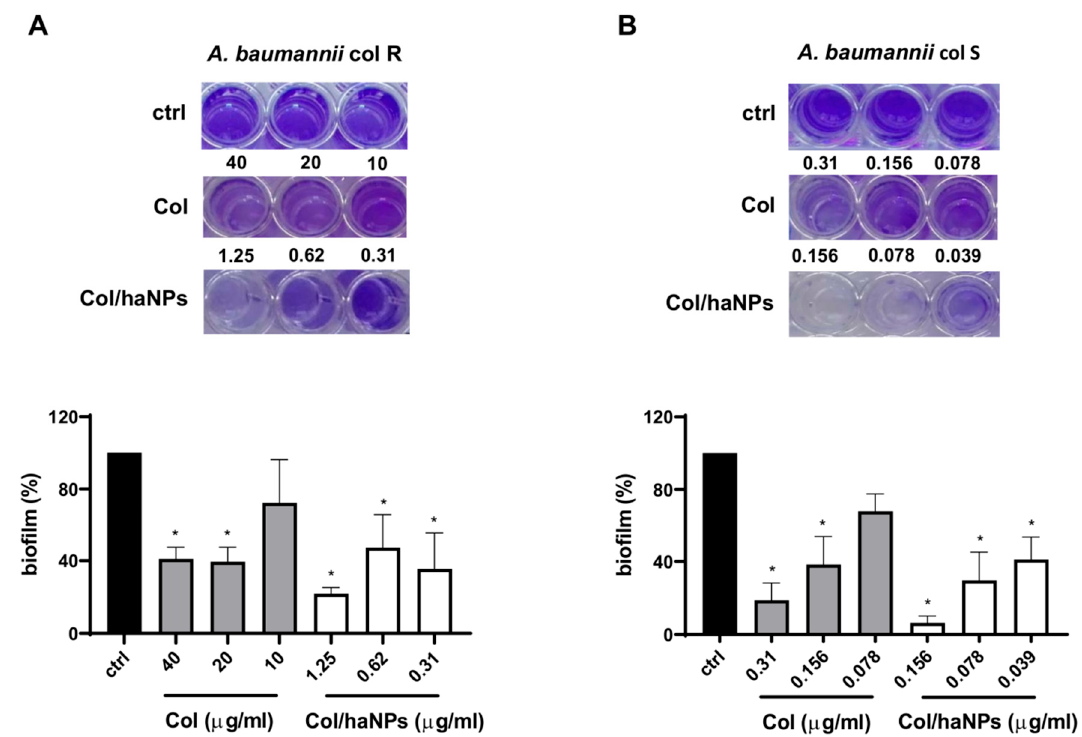
Figure 3. Antibiofilm activity of Col and Col/haNPs on A. baumannii Col R1 ( A ) and A.baumannii Col S ( B ). Bacteria were treated at concentrations of MIC, 1 / 2 MIC and 1 / 4 MIC. Biofilm formation of bacteria untreated was used as control and set as 100%. Results are the mean values ± SEM of three independent experiments. * p < 0.05 indicates statistical significance as compared to control by Student’s t-test.